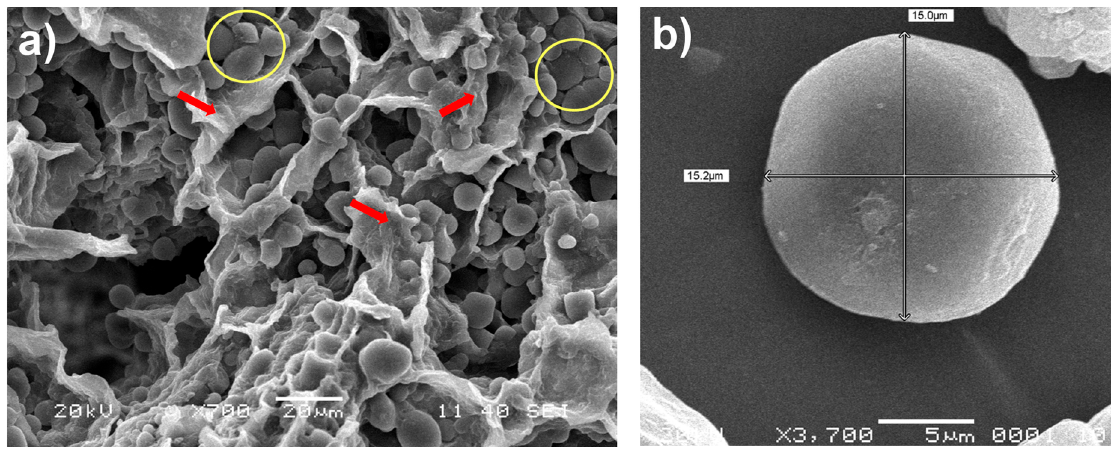
Figure 1. Scanning electron microscopy (SEM) of B. alicastrum flour: ( a ) starch granules embedded in a flour protein matrix; and ( b ) the size and shape of starch granules.